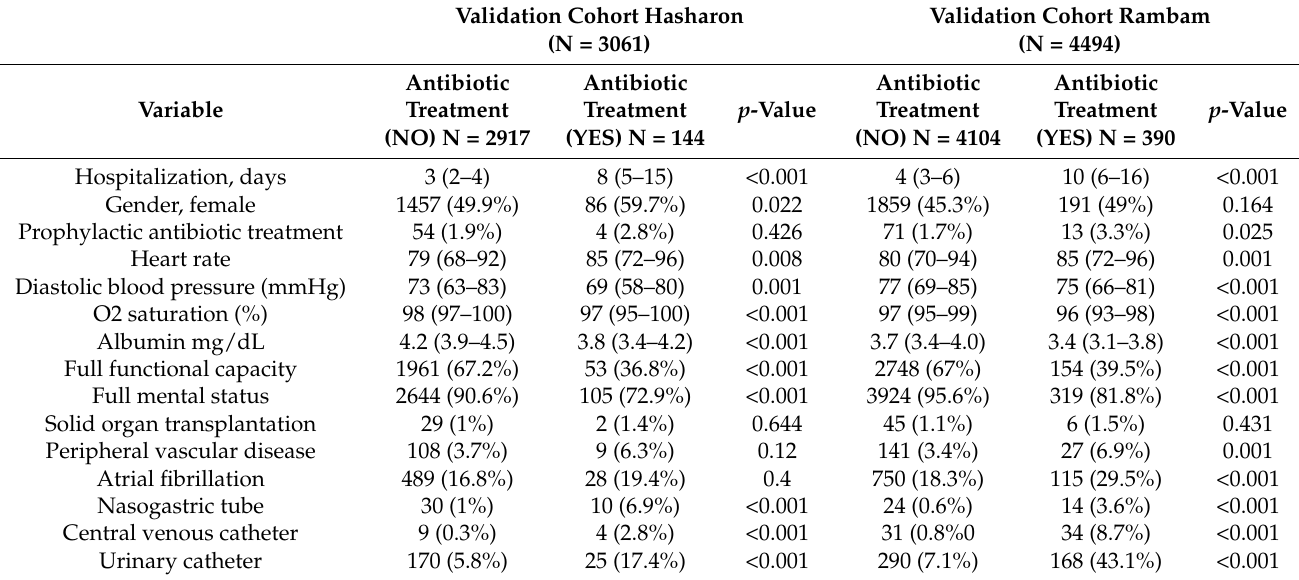
Table 4. Characteristics of patients in the validation